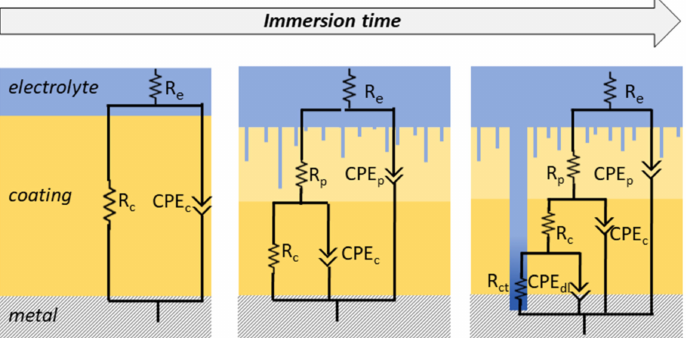
Figure 7. Representative schemes of electrical equivalent circuits (EECs) most employed to fit EIS data of polymeric coatings over immersion